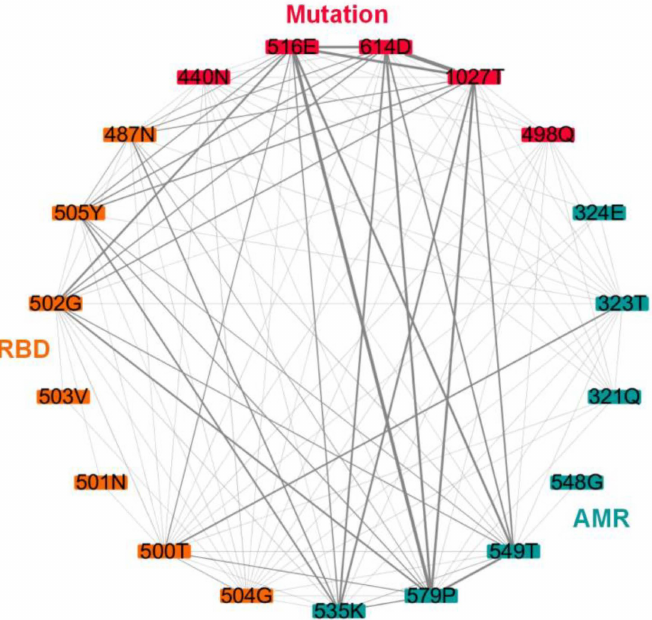
Figure 5. Interactions among top mutation sites with AMR and RBD. Red nodes: mutation sites; green nodes: AMR; orange nodes: